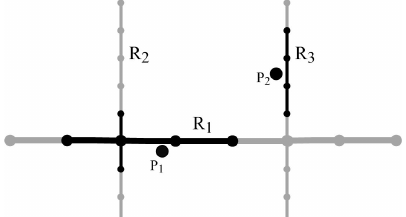
Figure 5. Illustration of expansion operation in a dynamic traffic